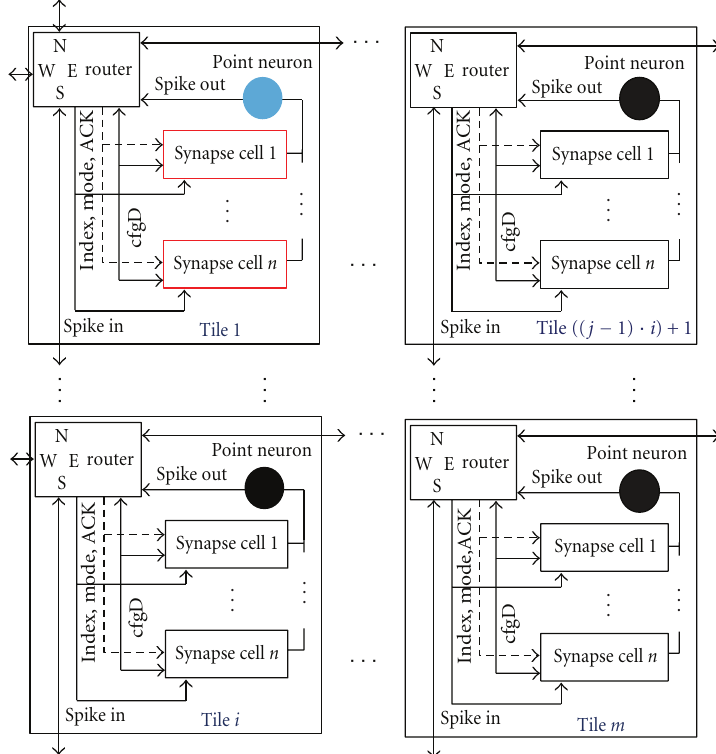
Figure 3: Mapping SNNs to EMBRACE: realisation of the neuron (2,1) and its n synapse connections to tile